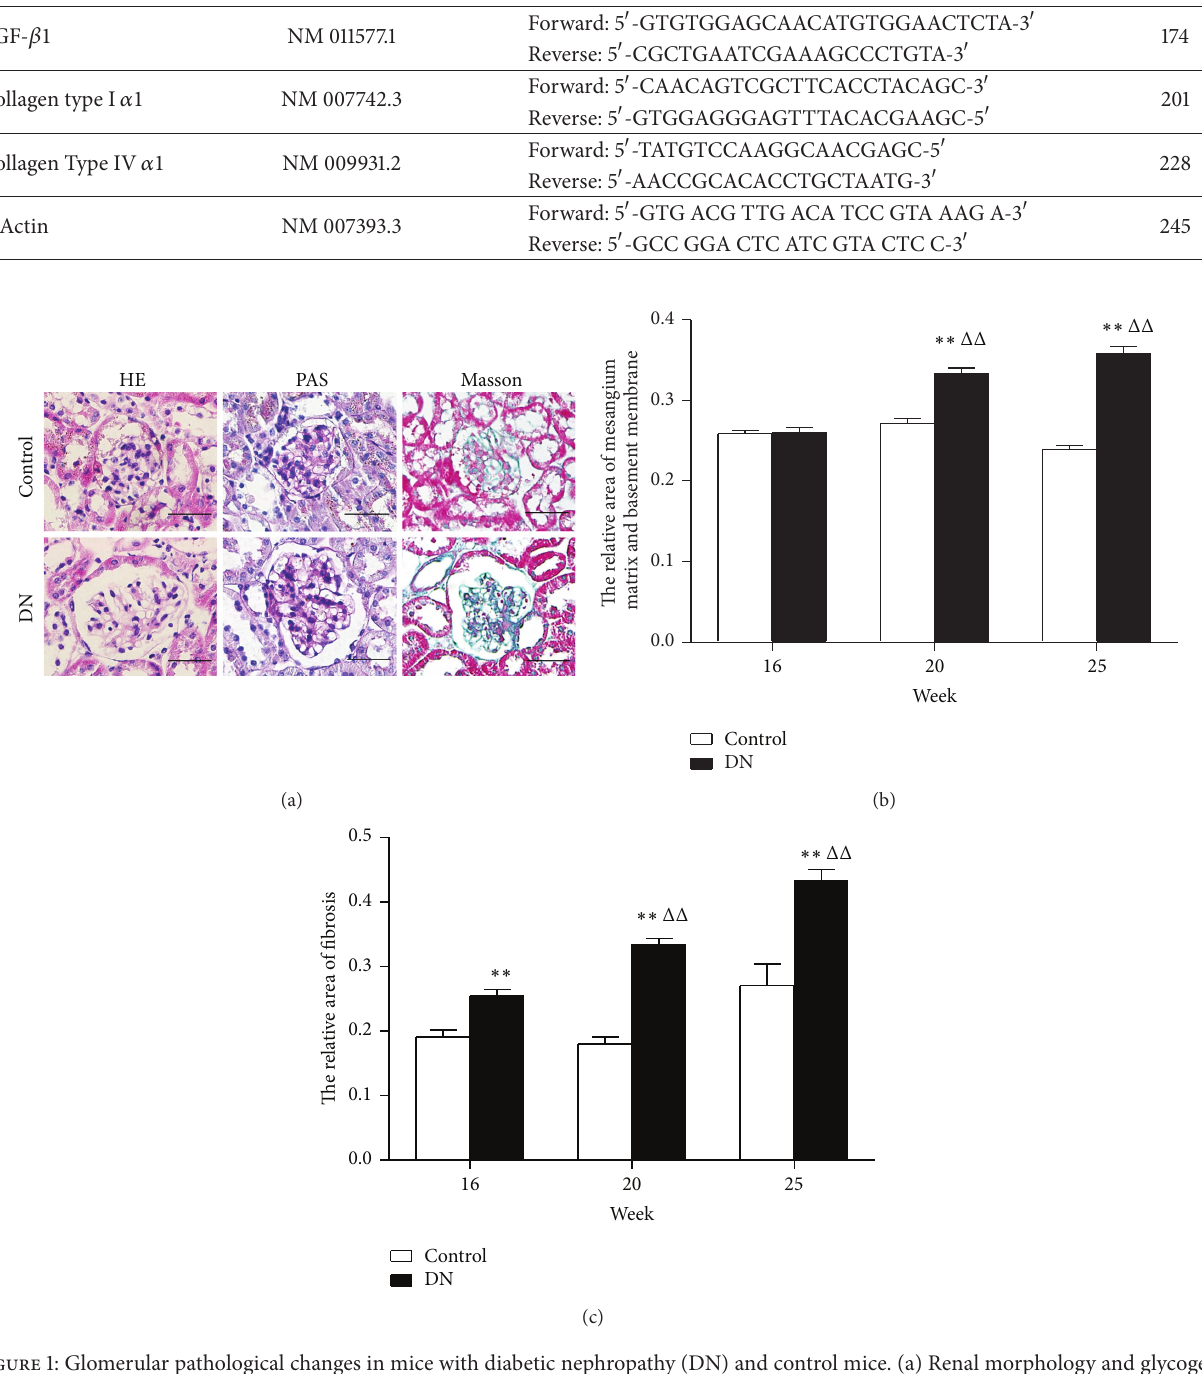
Figure 1: Glomerular pathological changes in mice with diabetic nephropathy (DN) and control mice. (a) Renal morphology and glycogen accumulation at 25 weeks evaluated by hematoxylin and eosin (HE) and periodic acid Schiff (PAS) staining, renal interstitial fibrosis detected by Masson trichrome staining. (b) Relative area of mesangium matrix and basement membrane at different times. (c) Relative area of renal interstitial fibrosis at different times. In both experiments, more than 12 glomeruli were evaluated in each mouse. Magnification in (a) HE, PAS, Masson: 400x. ∗ 𝑃 < 0.05 , ∗∗ 𝑃 < 0.01 versus age-matched control mice. Δ 𝑃 < 0.05 , ΔΔ 𝑃 < 0.01 versus 16-week-old DN mice. Scale bars, 50 𝜇 m. 𝑛 = 5 mice per